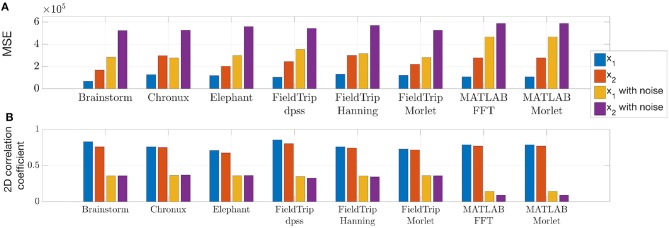
Mean squared error (A) and two-dimensional Pearson correlation coefficient (B) values between estimated and ideal spectra. These measures were computed for the time span from 1 to 3 s for the signals generated according to Equations (1, 2). The lower MSE and the higher correlation coefficient are, the closer is the estimated spectrum to the ideal spectrum.